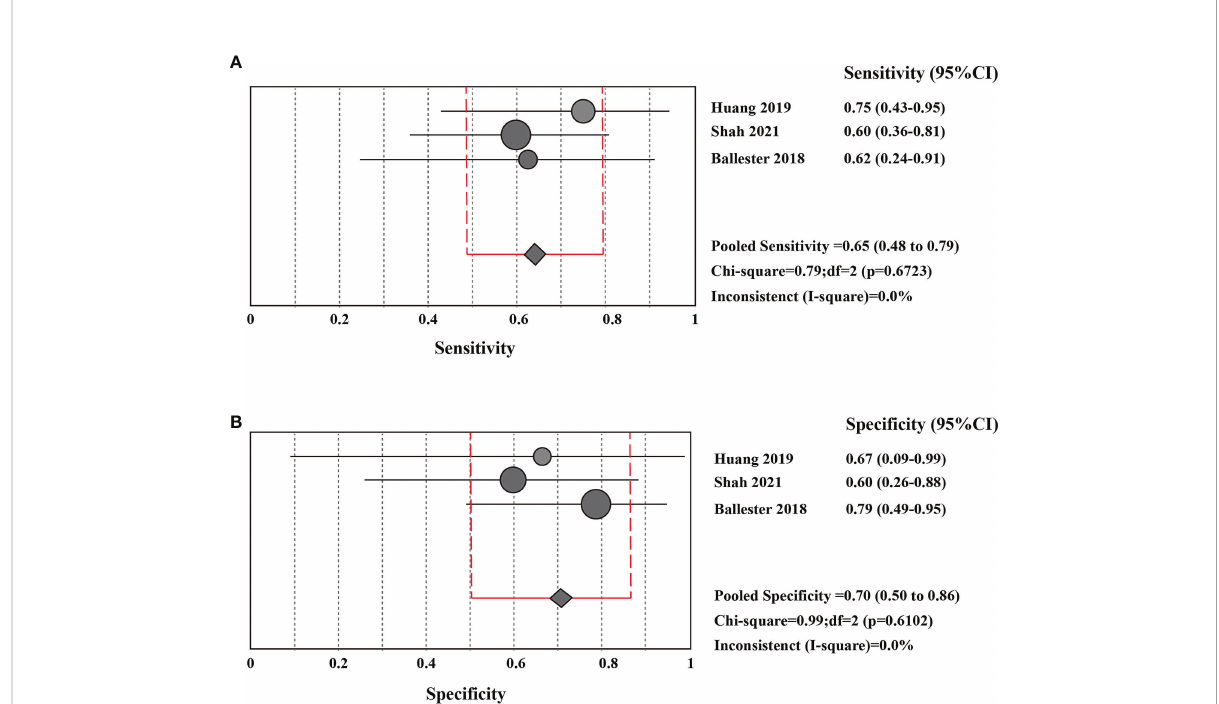
FIGURE 3 Pooled diagnostic value of CSF liquid biopsy for LM (A) . Pooled sensitivity of CSF liquid biopsy in diagnosis of LM. (B) . pooled speci fi city of CSF liquid biopsy in diagnosis of